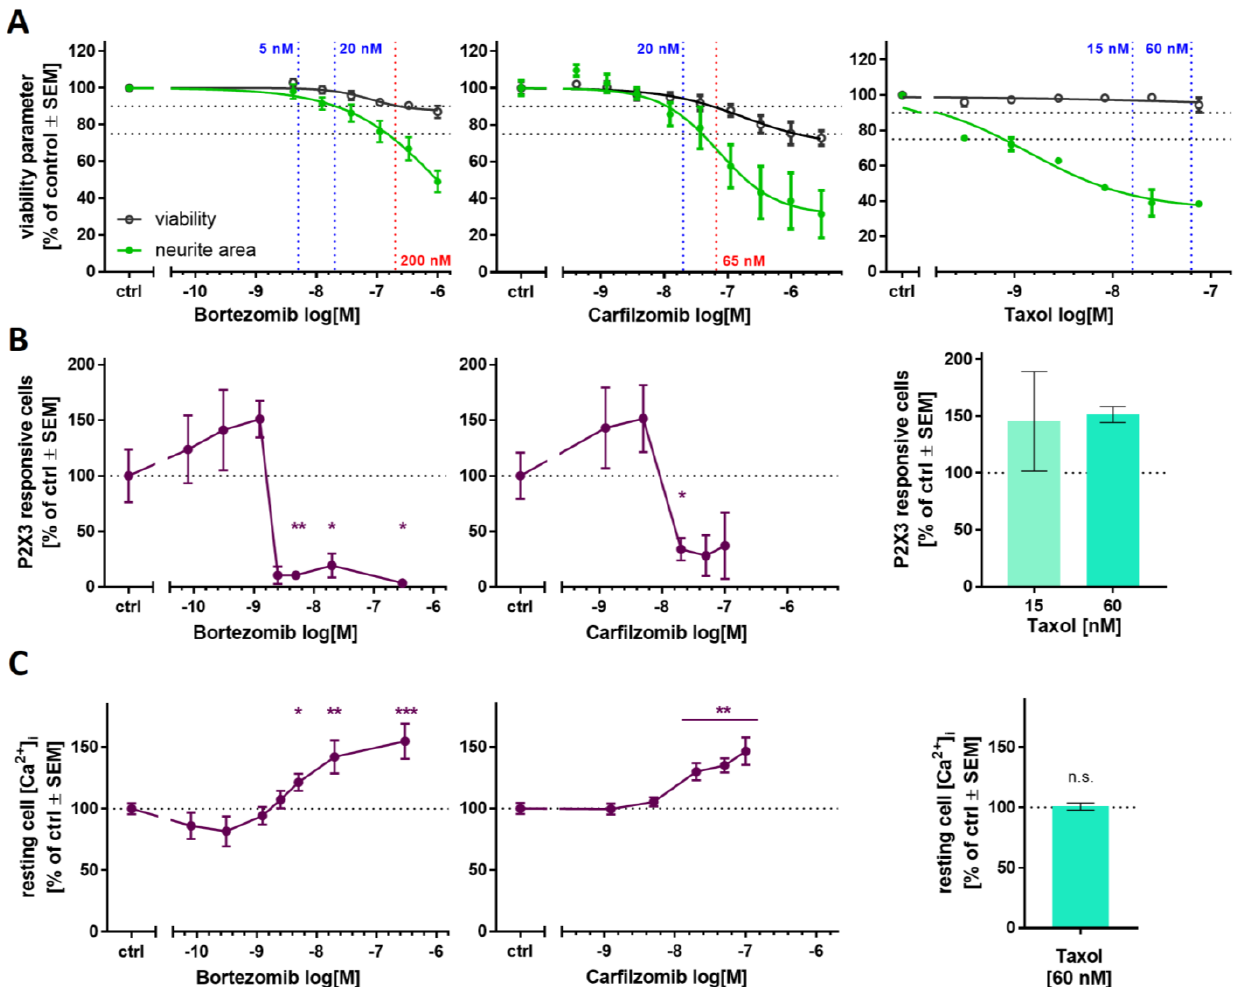
Figure 5. Ca 2+ signaling as a sensitive functional endpoint to assess proteasome inhibitor toxicity. The compounds bortezomib (left), carfilzomib (middle), and taxol (right) were investigated regarding their effects on different test endpoints. ( A ) The PeriTox test was used to assess their effects on neurite area and viability. Horizontal dashed lines at 90% and 75% indicate the cytotoxicity threshold and the neurite effect threshold, respectively. Vertical dashed lines indicate the lowest cytotoxicity-inducing concentration (red) and the concentrations further used for Ca 2+ imaging experiments (blue). ( B , C ) Sensory neurons (> DoD38) were pre-treated with the test compounds for 24 h, before